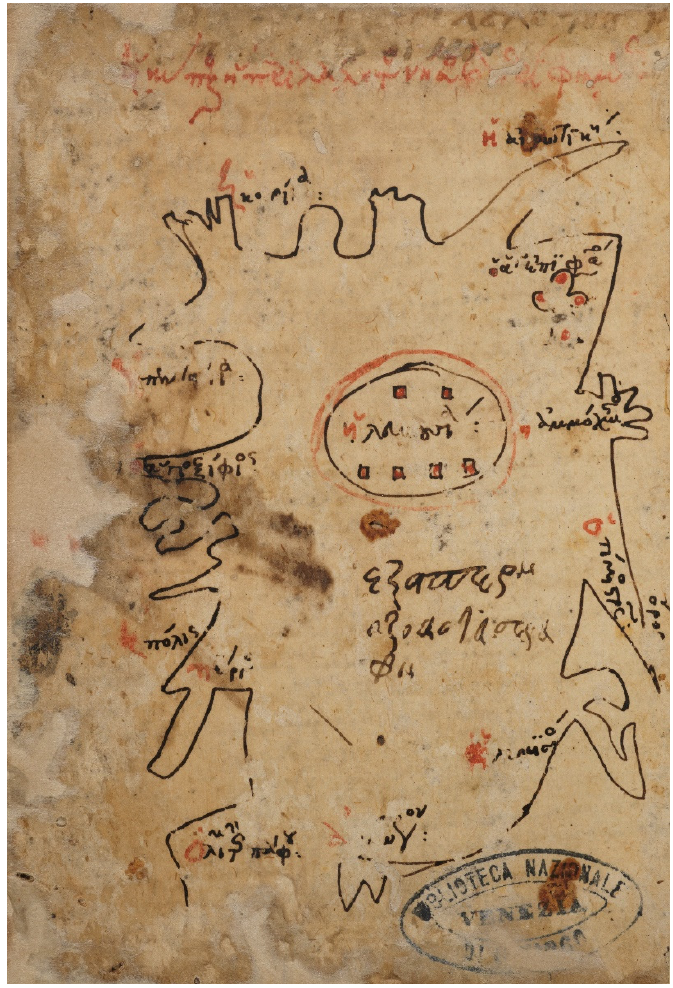
Figure 3. The Marciana map of Cyprus. Venice, Biblioteca Nazionale Marciana, gr. XI.21, f. 166v. Mid-fourteenth century (Reproduced with permission from the Biblioteca Nazionale Marciana, Venice).